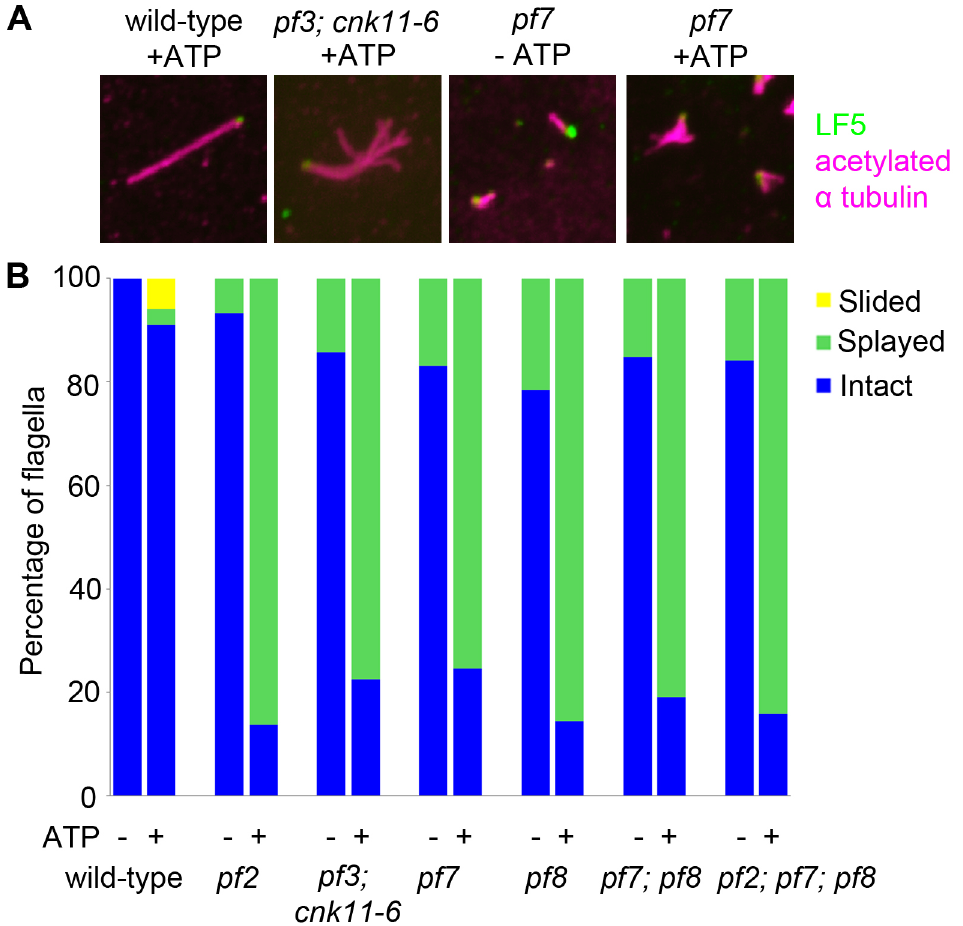
Fig 4. The pf7 and pf8 mutants show splaying phenotype in isolated axonemes similar to splaying in N-DRC mutants. (A) Fixed axonemes were stained with antibodies against LF5 (green) and acetylated α -tubulin (magenta). (B) Axonemes were scored as intact (blue), sliding (yellow), or splaying (green). At least 100 axonemes were score for each